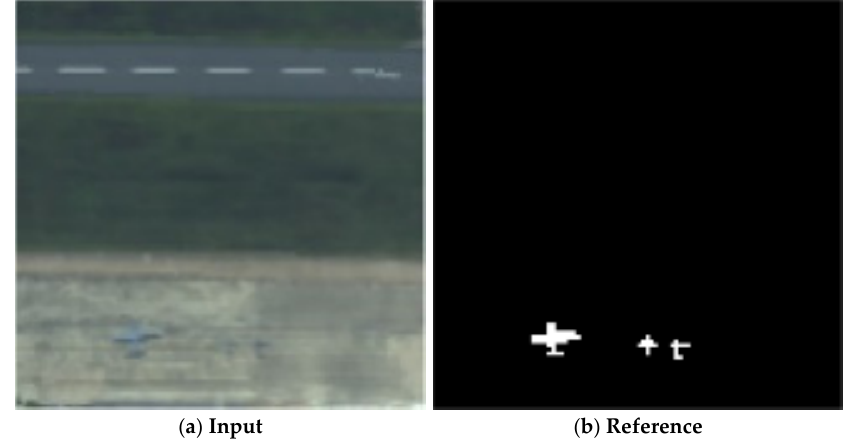
Figure 5. ROC curves for San Diego-II dataset with dual-window sizes (9,13) for CRD, CRBORAD, and SSCRD. Figure 6. Cont